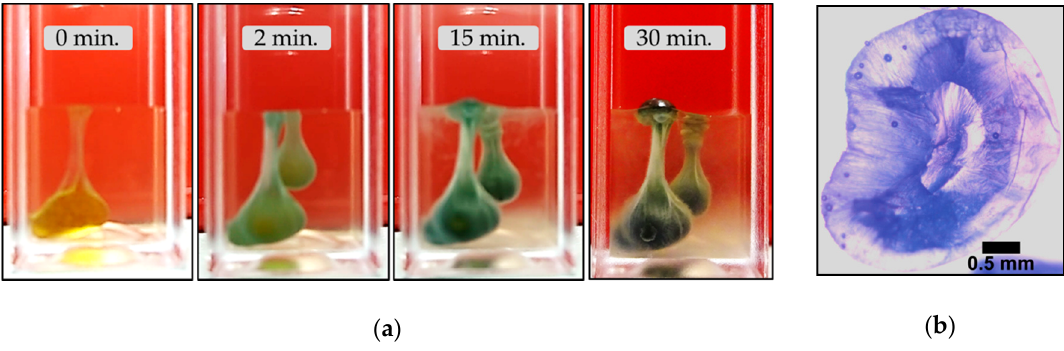
Figure 15. ( a ) Growth process of iron (II) chloride vesicles. The small drop was added 25 s later (width of the cuvette is 1.25 cm); ( b ) iron (II) sulphate vesicle with its